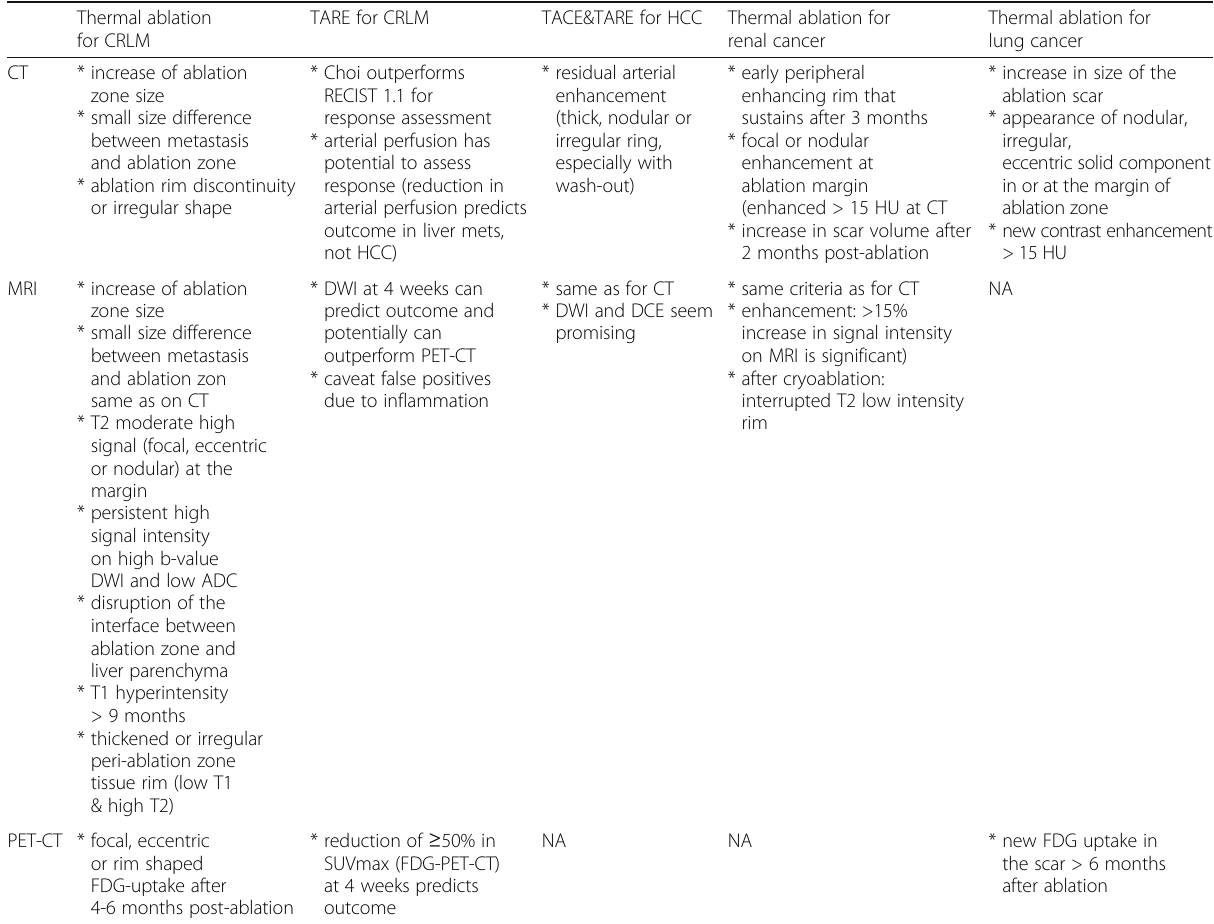
Table 3 Imaging features during follow-up per intervention Thermal ablation TARE for CRLM TACE&TARE for HCC Thermal ablation for for CRLM